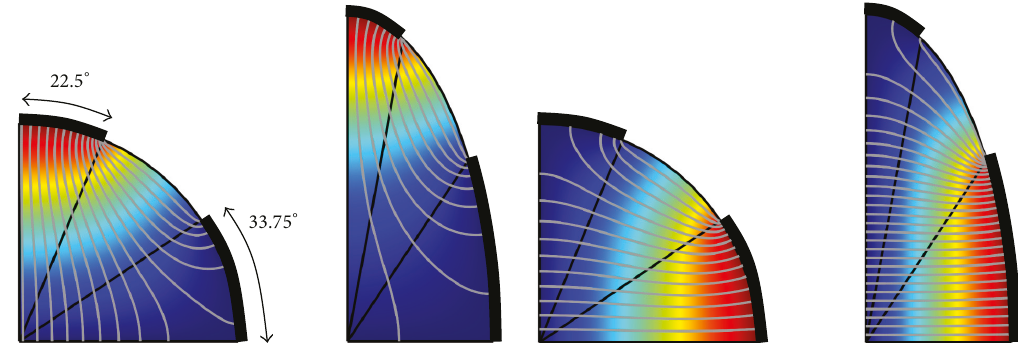
Figure 11: FEM-computation of input and output resistances of circular and elliptical devices with isotropic conductivity. Due to symmetry only a quarter of the real devices had to be modeled. The elliptical device is obtained from the circular one by stretching it times 1.5 in vertical direction and times 2/3 in horizontal direction. Contacts are thick black lines on the perimeter. The color coding denotes the electric potential (red = 1V, blue = 0 V) and the gray lines are current